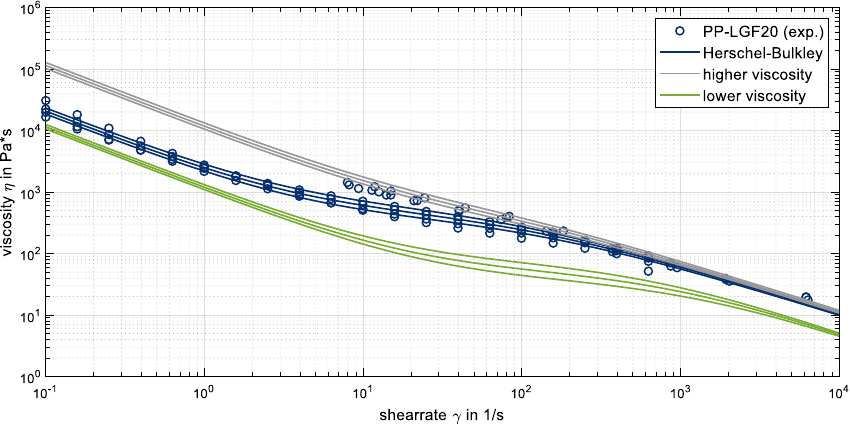
Figure 21. Shear rate and temperature dependent viscosity and analyzed viscosity curves.